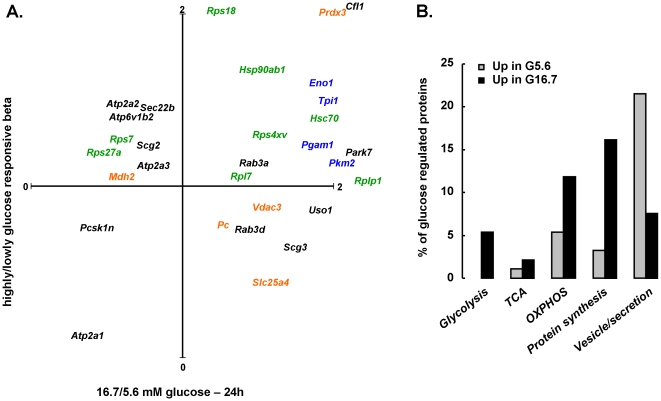
The phenotype of highly glucose responsive beta cells is partly mimicked by sustained glucose stimulation ex vivo.Of 93 proteins, 57 (61%) were up-regulated by 24 h 16.7 mM as compared to 5.6 mM glucose, and 36 (39%) down-regulated (p<0.05) in mouse islets [24]. Panel A shows their NCBI gene name in a plot, indicating their relative amount in highly/lowly glucose-responsive rat beta (Y-axis) and 16.7/5.6 mM glucose-exposed mouse islets. In blue, proteins of glycolysis; in green, protein biosynthesis; in orange, mitochondrial; in black: miscellaneous (Prdx3, Cfl1, Rps18, Rplp1, Park7 out of scale). Panel B shows % of glucose-regulated proteins (black: glucose-induced, gray: glucose-suppressed) that belong to indicated functional ontologies. For 30 of 93 proteins, molar abundances could be measured in rat highly/lowly glucose-responsive beta cells.